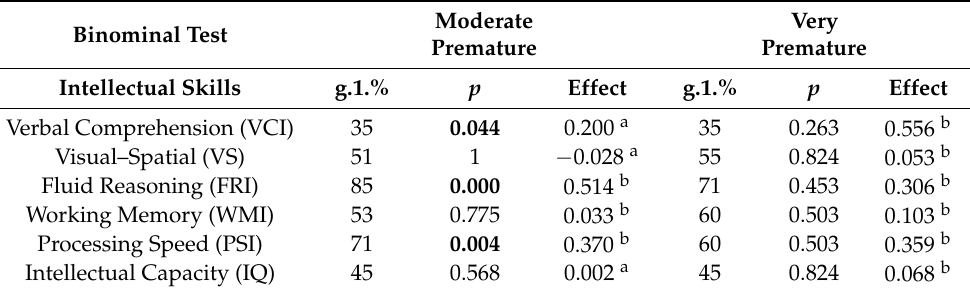
Moderate Premature